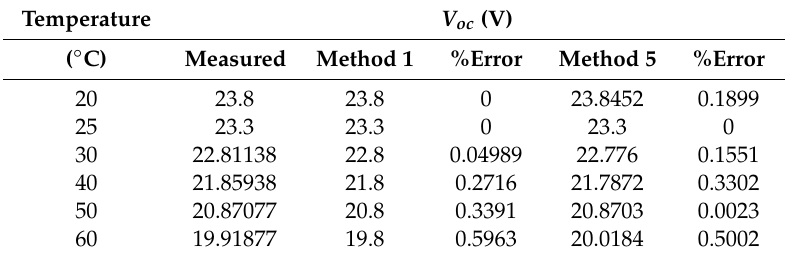
Table 11. Calculated and measured V oc (V), and relative error of the shell ST40 module under di ff erent temperatures and an irradiance of 1000 W / m 2